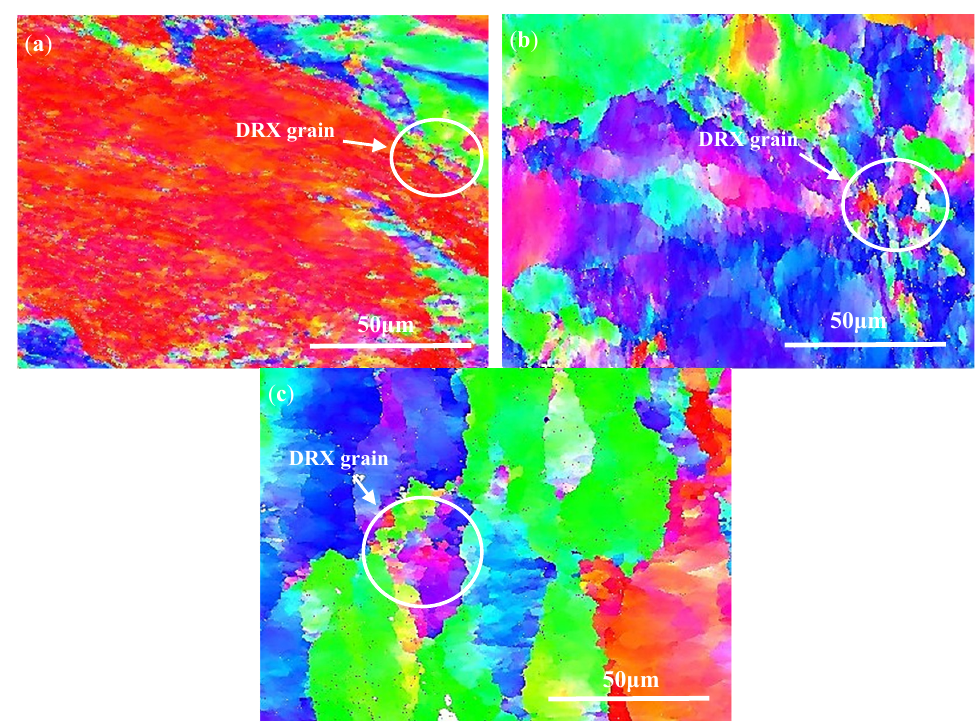
Figure 12. EBSD images of the deformed grains at α + β phase field, as well as strain rate of 0.01 s − 1 : ( a ) 700 ◦ C, ( b ) 730 ◦ C, and ( c ) 760 ◦ C.